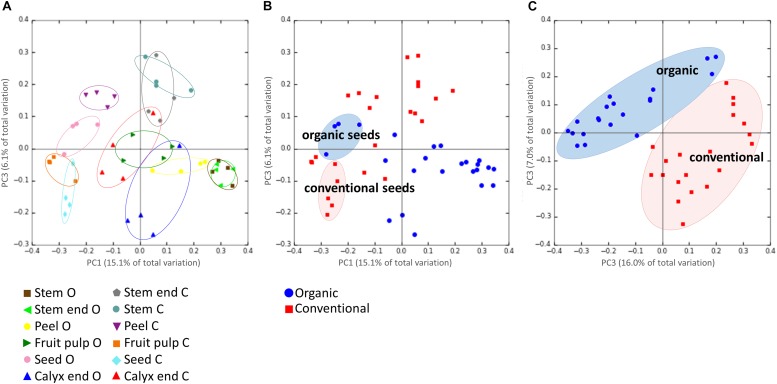
Beta-diversity analysis on microbiota composition dependencies. Panel (A) shows the microbiota composition grouped by the tissue of the respective management group, where O and C in the bottom legend denote for organically and conventionally managed apples, respectively. Panel (B) visualizes composition of all tissue replicates, colored by organic (blue circles) and conventional (red squares); seeds of organically and conventionally managed apples are highlighted. In Panel (C), same dataset is shown but seed samples of both management groups were excluded. PCoA plots are based on unweighted UniFraq distance matrix.